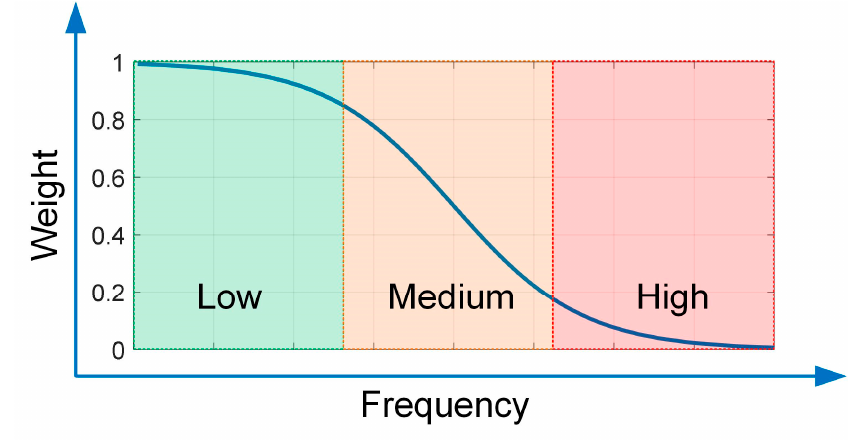
Figure 2. Low-pass vector.